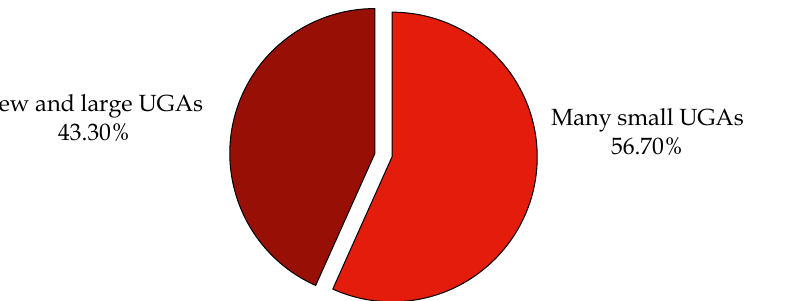
Figure 8. Responses on the perception of safety of small vs. large UGAs in regard to experience from the restriction measures (quarantine) to minimize the spread of COVID ‐ 19 (research question: “Based on your experience from the restriction measures (quarantine) to minimize the spread of COVID ‐ 19, do you think it is safer to have a lot small UGAs in your municipality, or few and large ones?”). The visit frequency to urban green areas prior to the COVID-19 outbreak and the subsequent restrictions was varied (Figure 9). In general, 34.5% would visit an urban green space more than once a week, while 23.9% of the respondents would visit it only once a week.